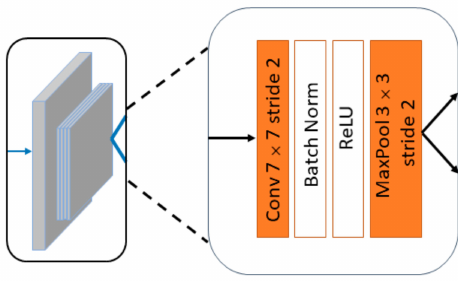
Figure 2. Architecture of the preprocess.